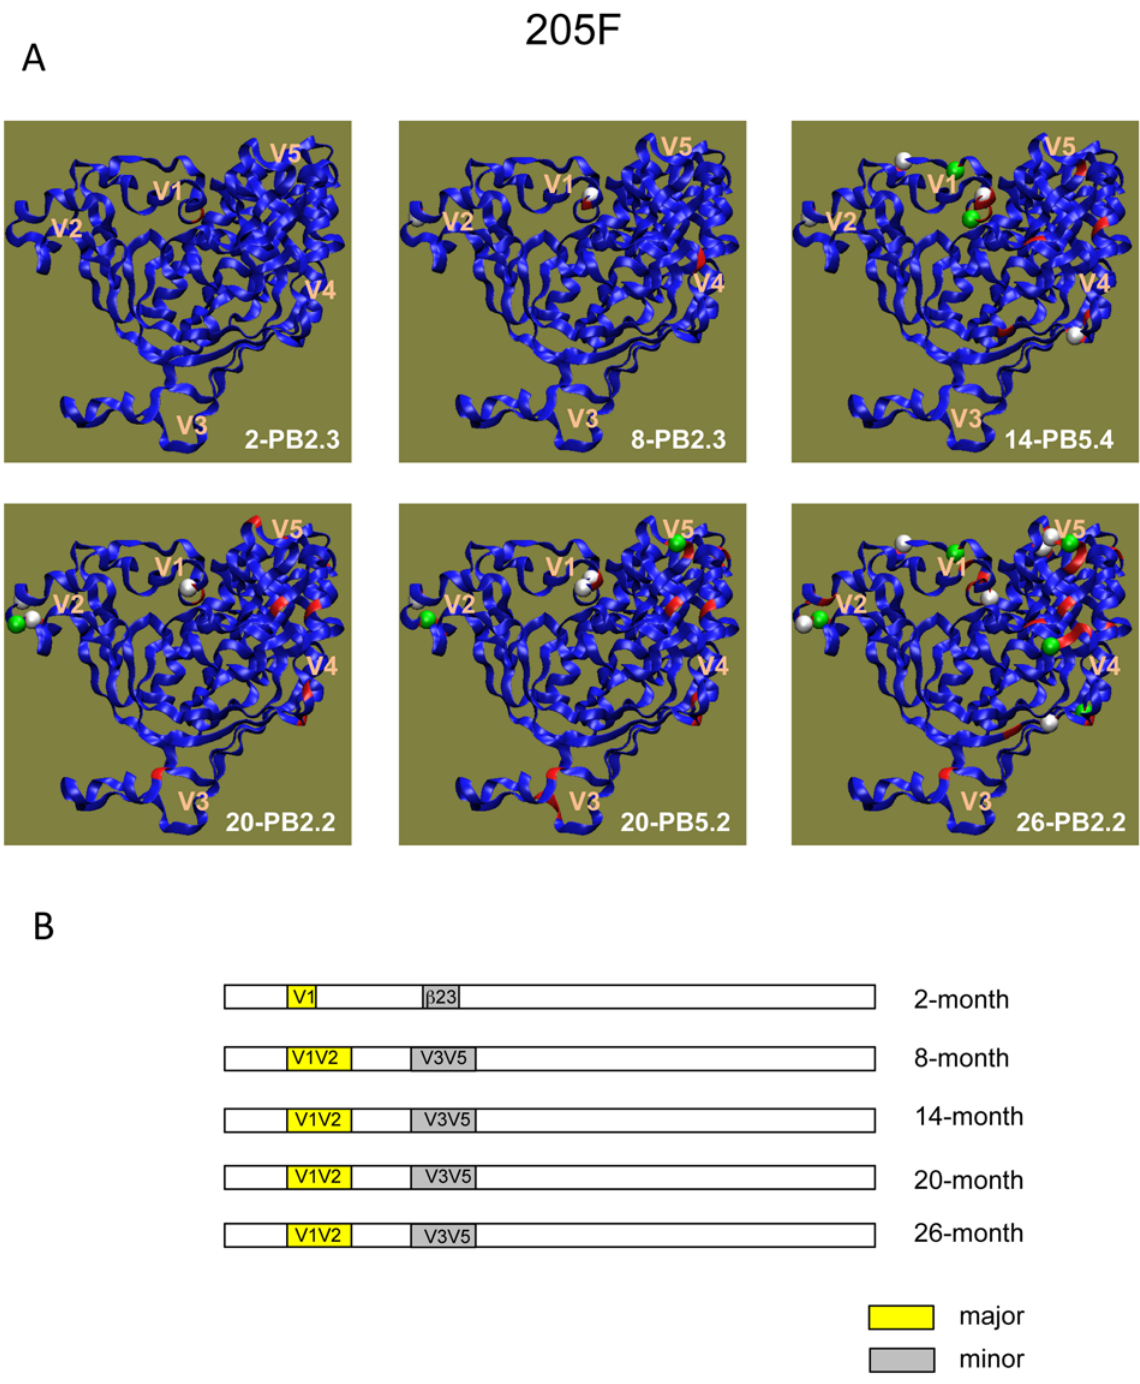
Figure 8. Nab escape in 205F is V1V2-dependent. (A) A 3-dimensional representation of the gp120 amino acid sequence for a different longitudinal Nab escape variant Env is shown in each panel. The time point and clone is indicated in each panel. The blue gp120 backbones were generated by homology modeling of the 0-month Env sequence onto the CD4-liganded HIV-1 YU-2 gp120 structure [54], with modeled V1V2 and V3 loops as described previously [25]. Red indicates amino acid changes relative to the 0-month Env sequence. Spheres indicate changes in a potential N-linked glycosylation sites (green=loss, white=gain). (B) Schematic representation of the Env domains contributing to Nab escape at each time point. Yellow indicates that the domain that had a major effect on Nab resistance; gray indicates the domain that made a minor contribution to Nab resistance. For more detail, see Fig. S5.